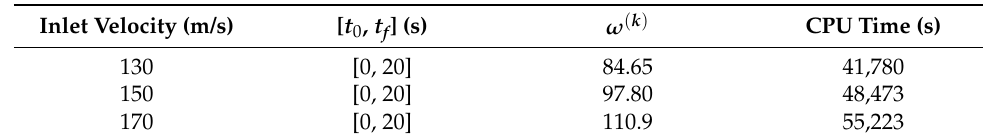
Figure 8. Example 2: Mesh of flow around an airfoil (NACA0012). Table 2. Example 2: Sampling cases.